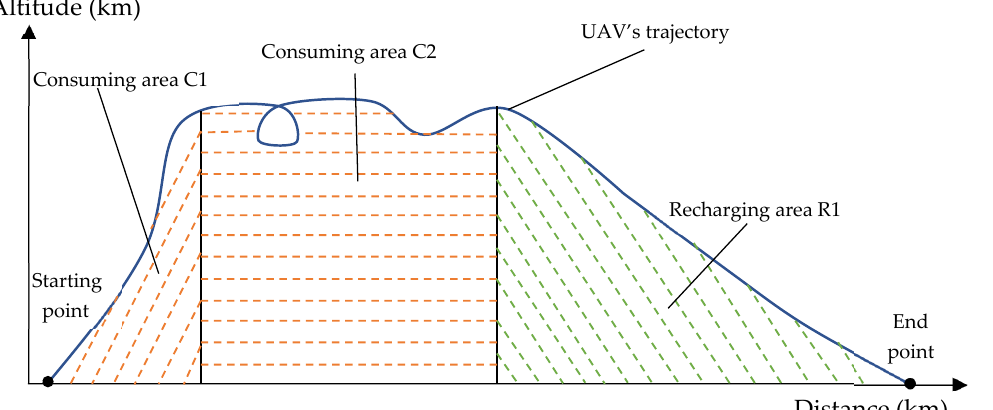
Figure 3. UAV flight scenario to get maximum efficiency.